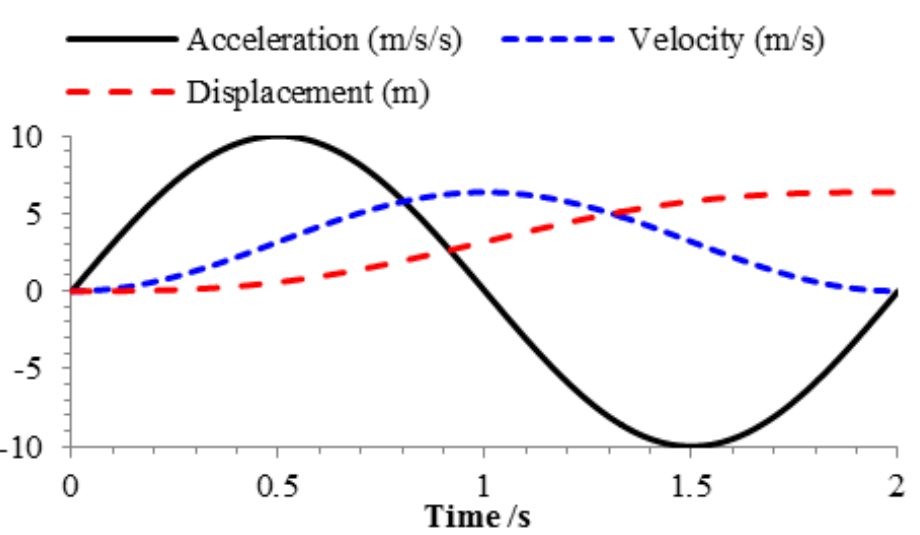
Figure 6. Time histories of the input dynamic loading.